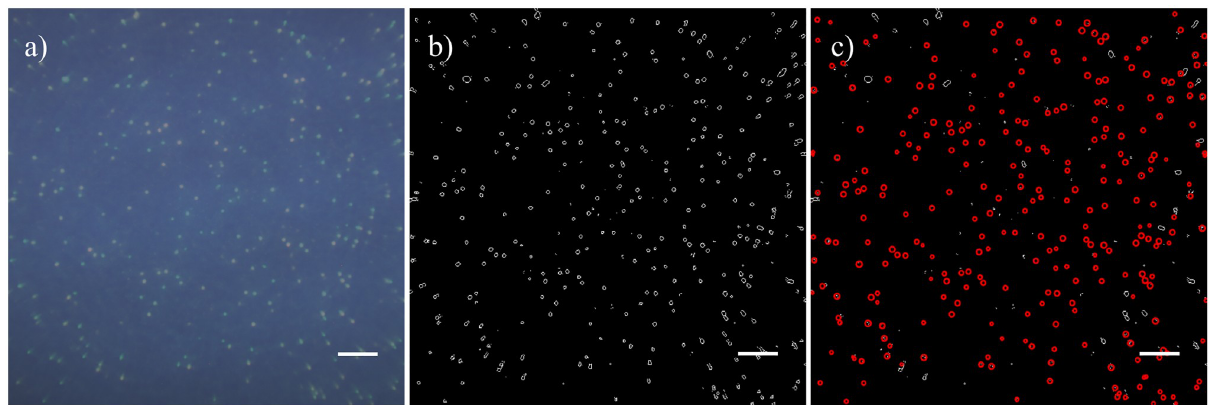
Fig 4. Segmenting WBCs from the FOV. (a) Image of AO stained whole blood taken under UV excitation in the 1 mm x 1 mm FOV, (b) WBCs after applying a Sobel filter, and (c) the segmented WBCs, displayed as the red circles, used for analysis based on the size criteria. Scale bars represents 100 μ m.